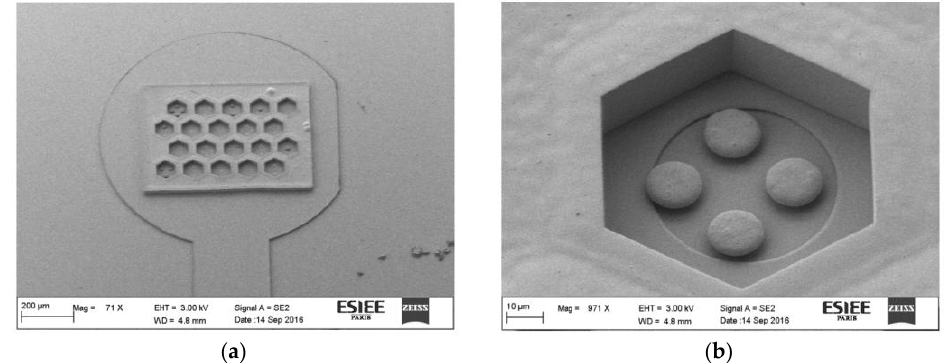
Figure 2. SEM image of the implant ( a ) General view of the implant head on soft substrate; ( b ) Detail of the configuration consisting of 4 protuberant electrodes embedded in the well formed by the ground plane.